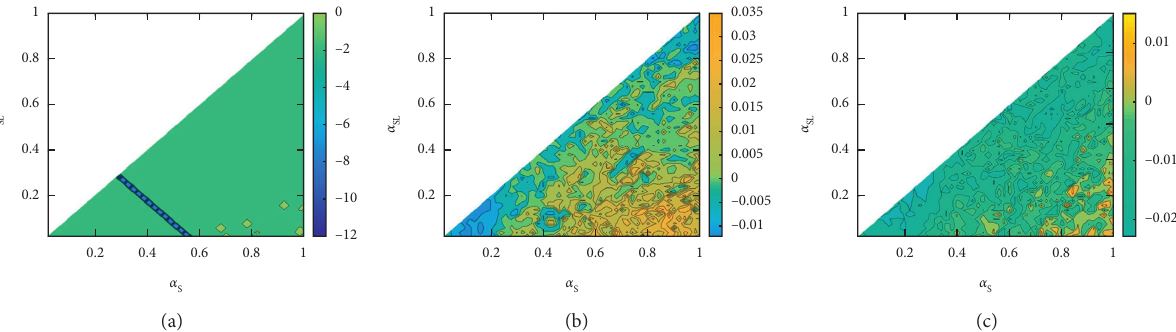
Figure 18: LLE diagram of supply chain nodes under the scenario of random demand obeying uniform distribution from local perspective � 5. (a) The retailer’s LLE chart. (b) The LLE chart of the distribution center. (c) The LLE chart of the combined system when G d � 2 and G 1 from the decision